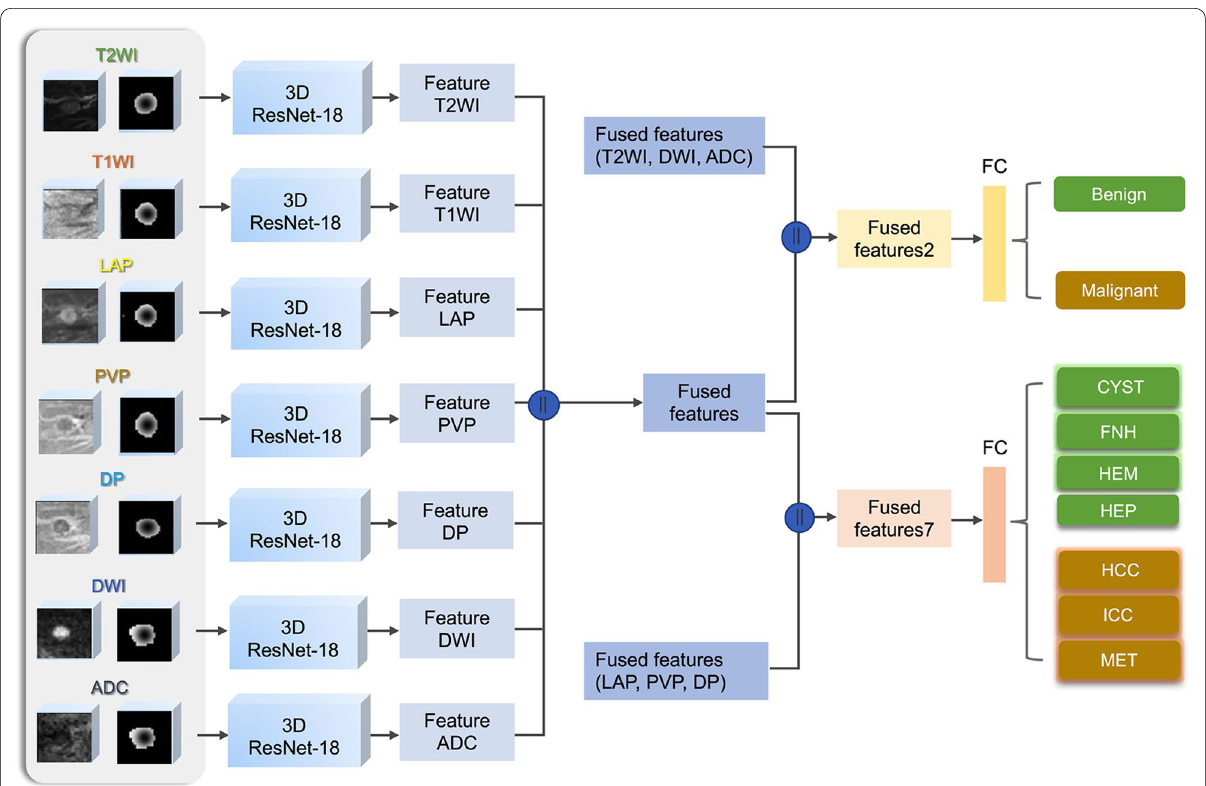
Fig. 1 Architecture of the proposed deep learning